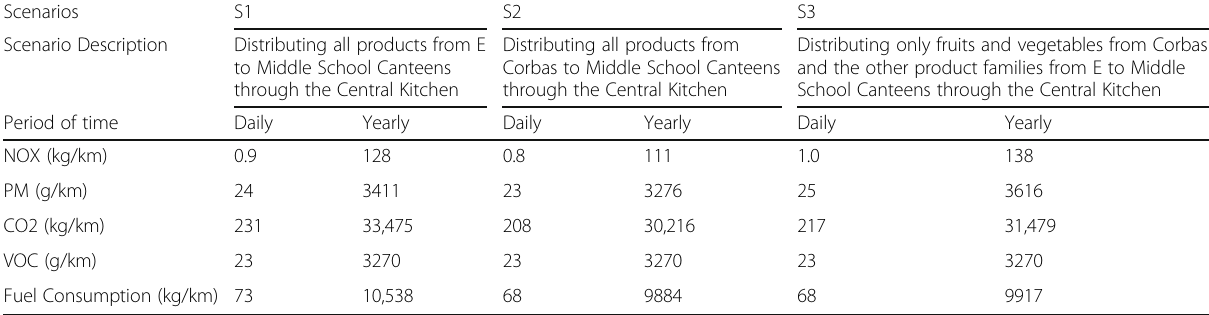
Table 11 The scenarios VRP environmental evaluation results for the 3,5 t vehicle and 14 t vehicle calculated according VRP-SS